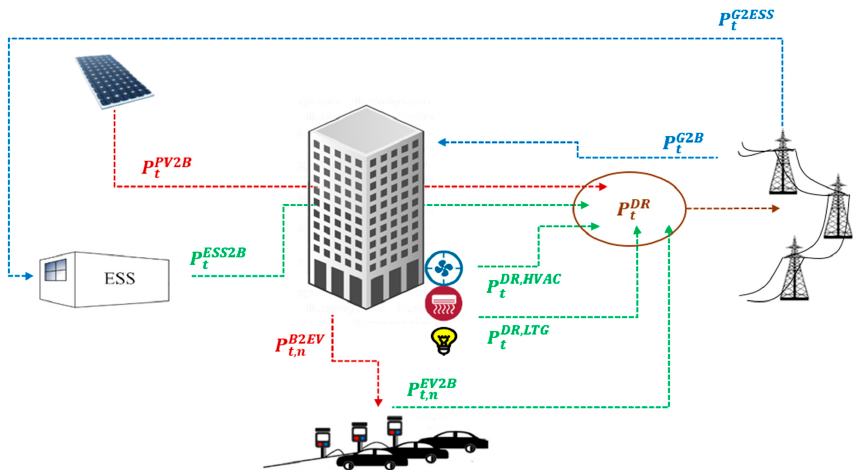
Figure 1. Structural diagram of the residential building distributed energy resource (DER) optimization system in demand response (DR) participation time interval. system in demand response (DR) participation time